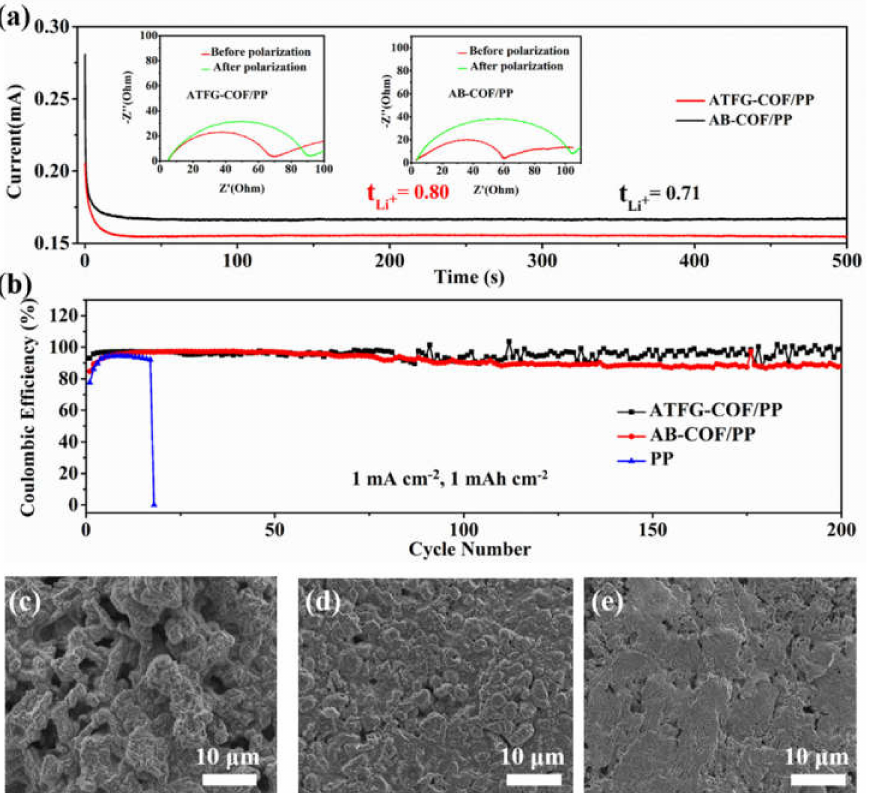
Figure 3. ( a ) Lithium-ion transference number measurement of the Li (cid:107) ATFG-COF/PP (cid:107) Li and Li (cid:107) AB-COF/PP (cid:107) Li; ( b ) the coulombic efficiency at 1 mAh cm − 2 and 1 mA cm − 2 of the Li (cid:107) ATFG-COF/PP (cid:107) Cu, Li (cid:107) AB-COF/PP (cid:107) Cu, and Li (cid:107) PP (cid:107) Cu; ( c – e ) SEM images of cycled Li surface morphology at Li (cid:107) PP (cid:107) Li, Li (cid:107) AB-COF/PP (cid:107) Li, and Li (cid:107) ATFG-COF/PP (cid:107) Li after 30 cycles at 1 mAh cm − 2 and 1 mA cm − 2 ,